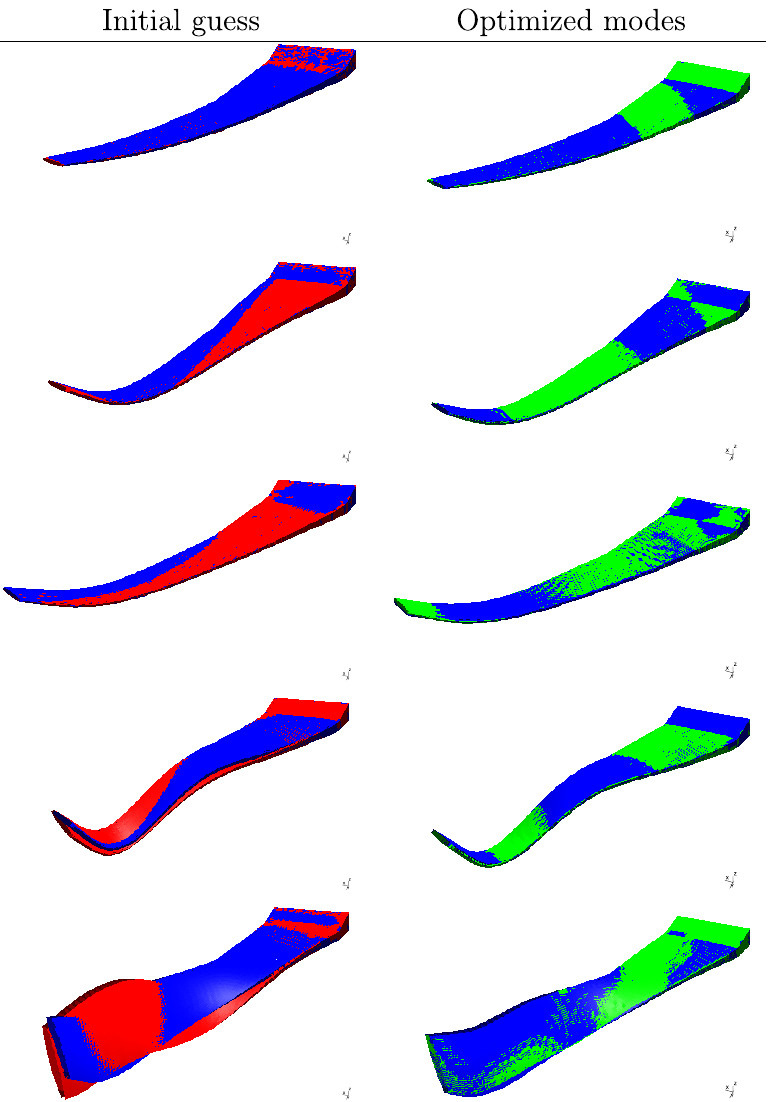
Fig. 4. On the left, modal results of the first optimization iteration (initial guess, in red) overlapped with the reference ones (blue). On the right, optimized modes (green) overlapped with the reference ones for the case of N = 5